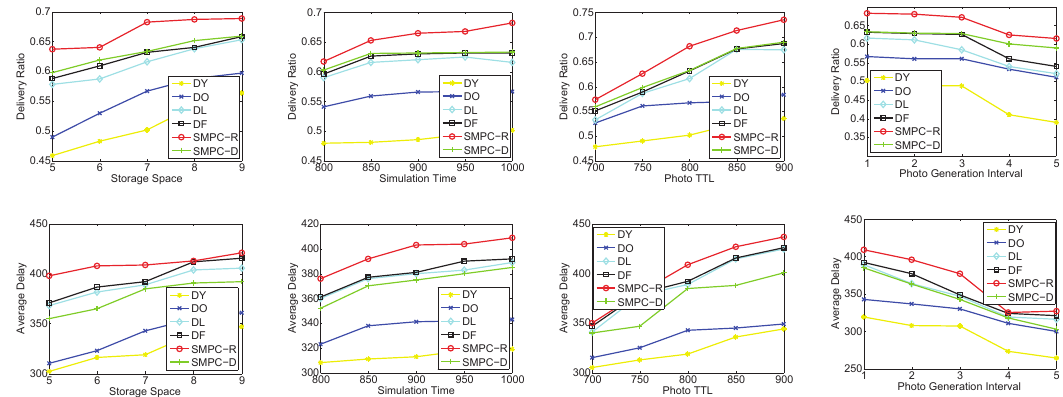
Figure 12. Performance comparisons on the random-waypoint mobility pattern: delivery ratio and average delay.